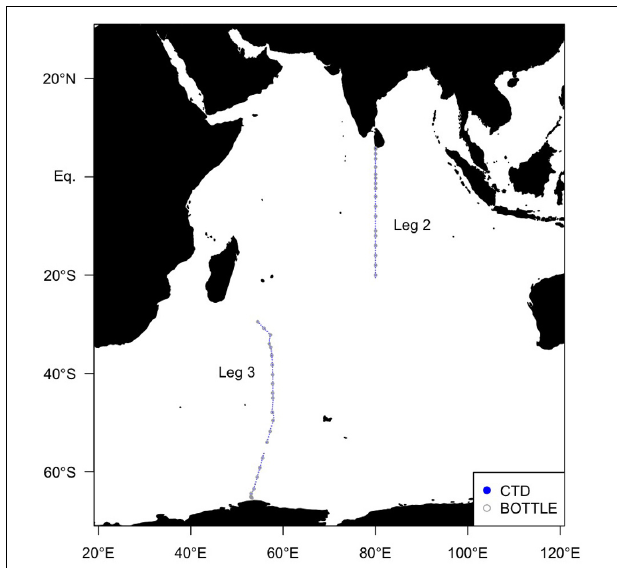
FIGURE 1 | Map of sampling sites in the Indian Ocean in this study. Solid blue circles indicate sites where the FOM data were obtained using an in situ fluorometer, and open gray circles indicate sites where the FOM data were also measured using a shipboard benchtop